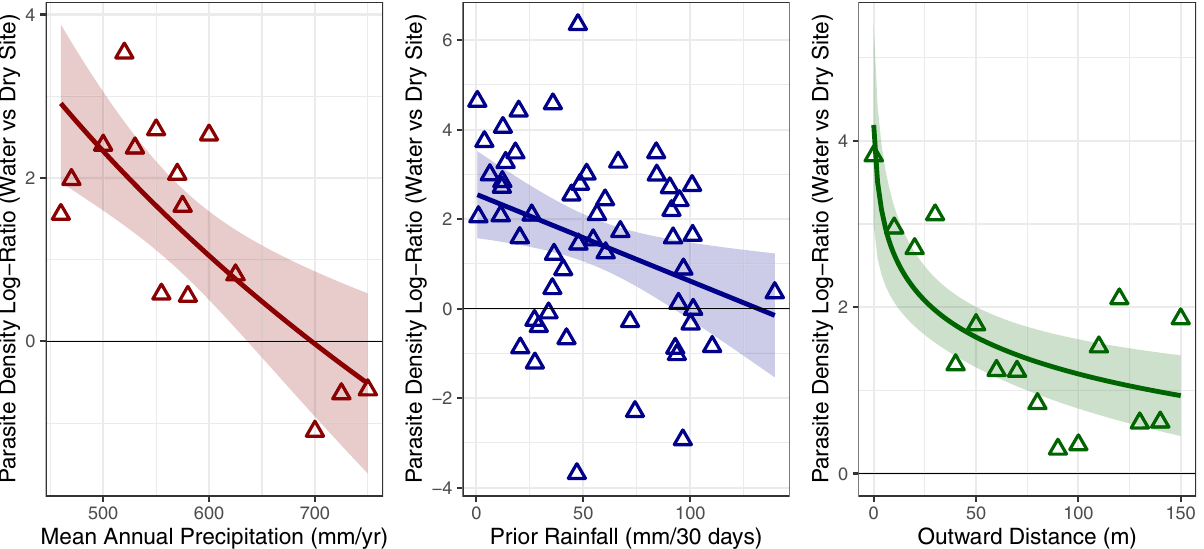
Fig. 4 Visualized log ratio of parasite density from dung at watering holes relative to matrix sites across differing levels of mean annual precipitation, prior rainfall, and outward distance. Points and lines that lie above 0 indicate increased density at water relative to matrix sites. Points represent averages for each value of MAP, prior rainfall, or outward distance; colors show different covariations with water limitation. Lines represent best linear fi ts (± SE) to the points. Species-speci fi c fi gures illustrating zero-in fl ated data are available in Supplementary Appendix Fig. S8. Source data are provided as a Source Data fi